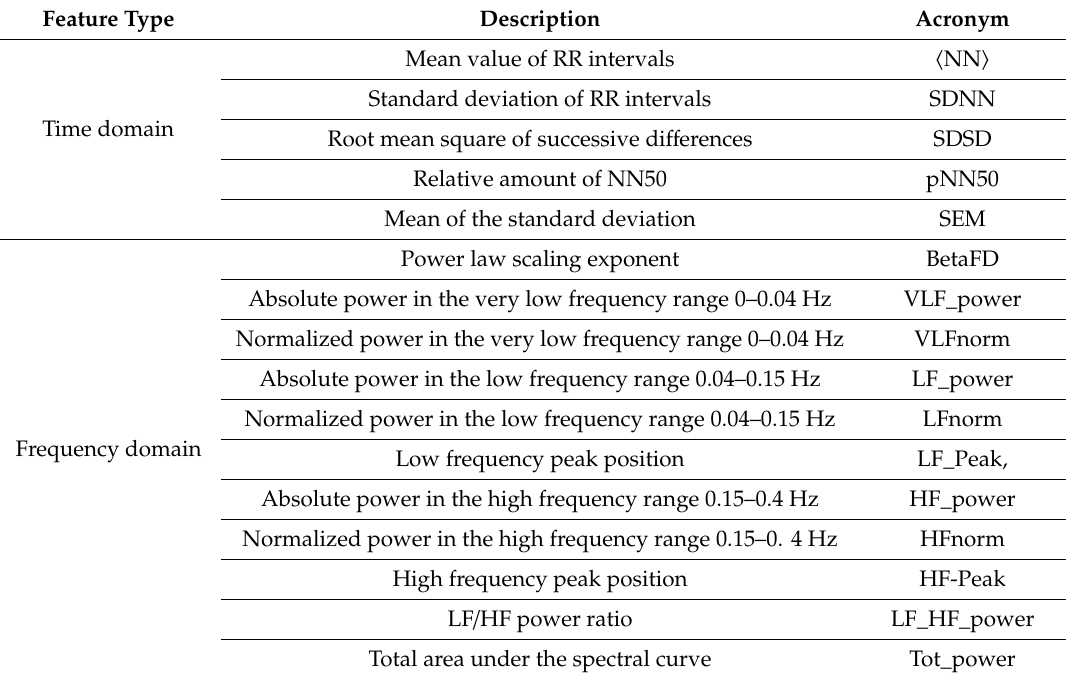
Table 1. Time domain and frequency domain HRV features included in the